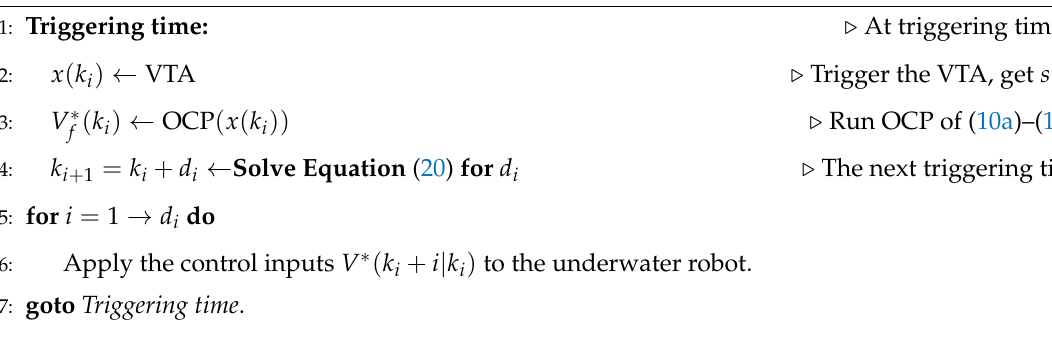
Algorithm 1 Real-time algorithm of the proposed self Triggered PBVS-NMPC